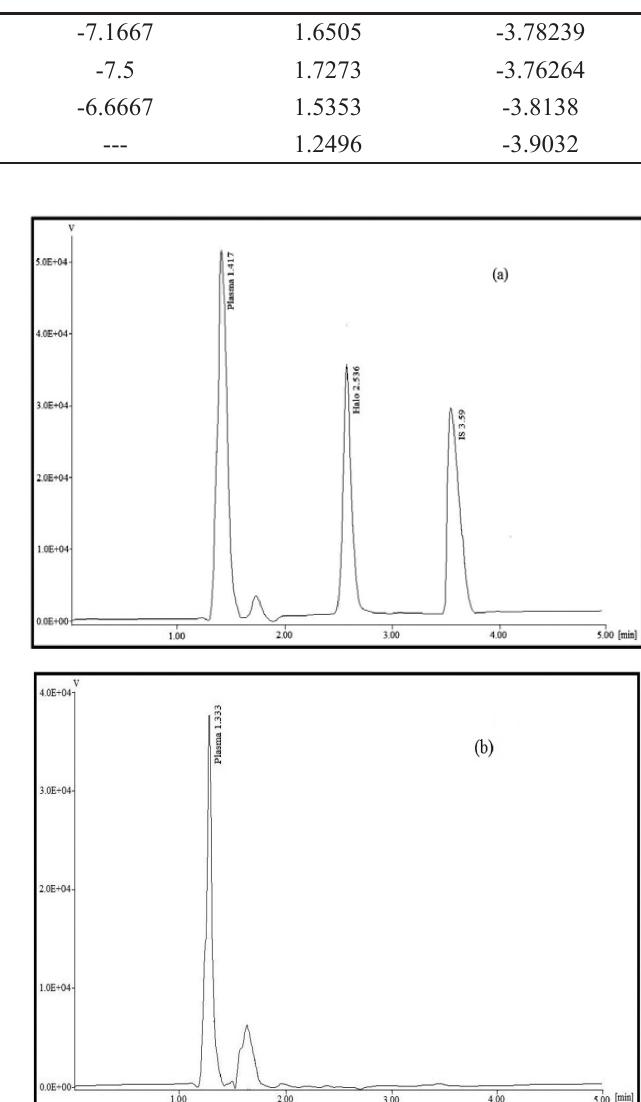
TABLE V - Various parameters for calculation of shelf life Temperature